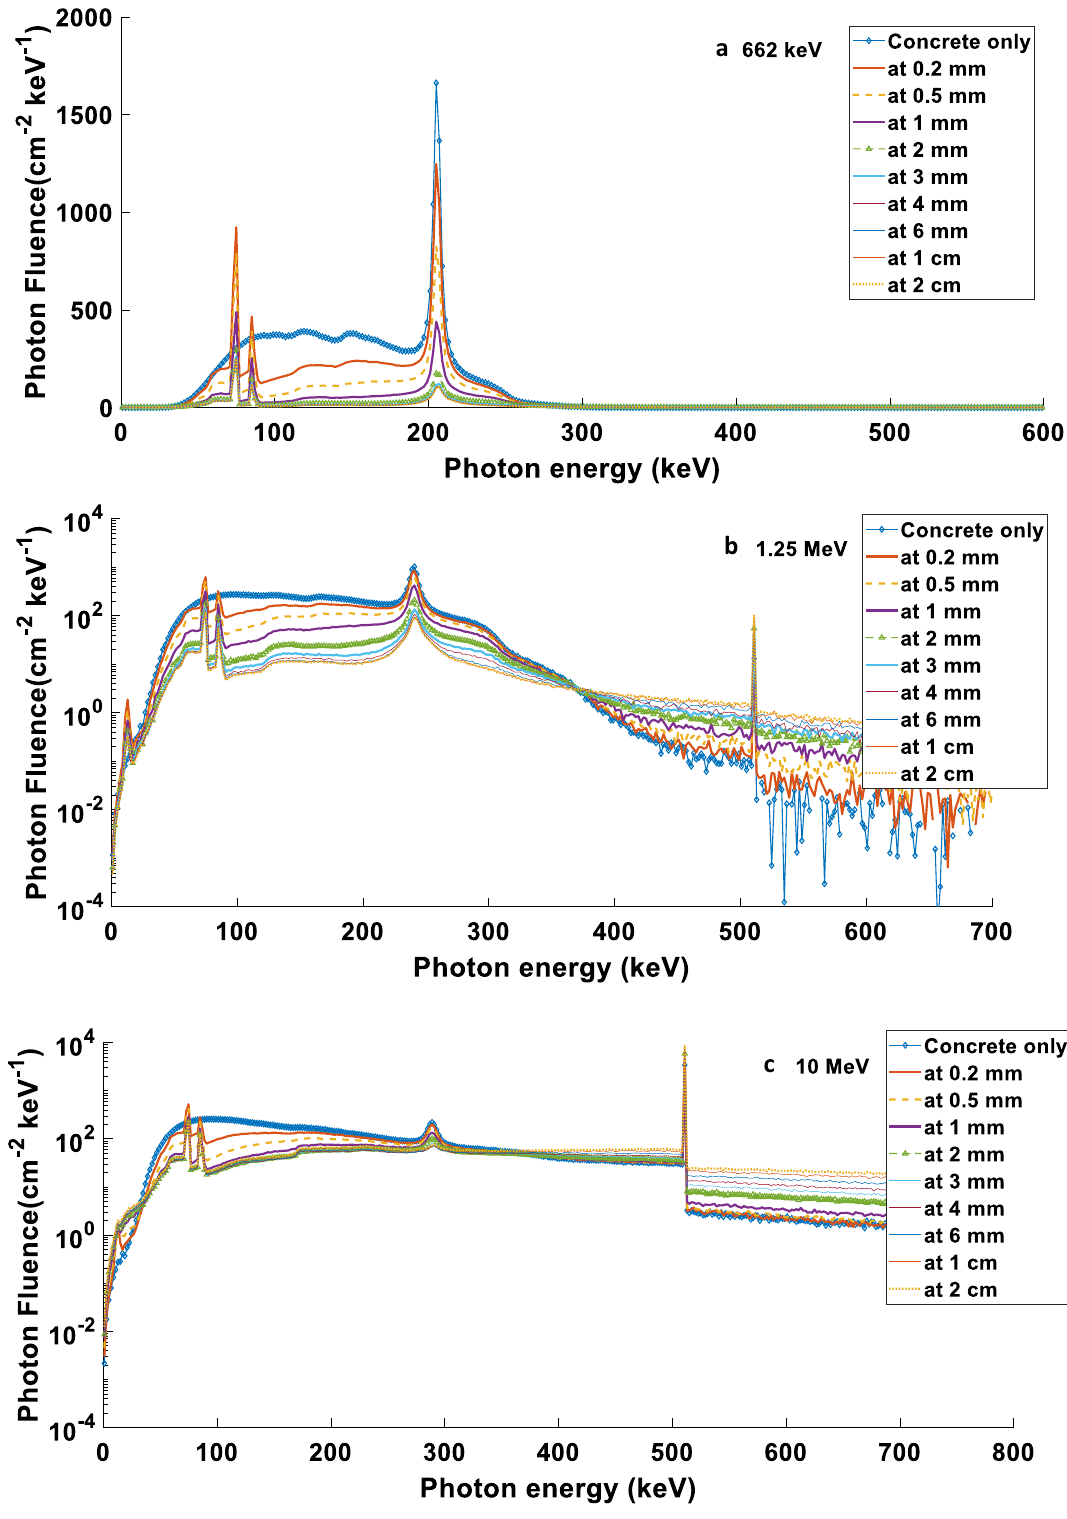
Figure 5. The fluence spectra of backscattered photons with the various thicknesses of Pb layered over ordinary concrete at reflection angle of 135° and incident photon energies of ( a ): 662 keV, ( b ): 1.25 MeV, and ( c ): 10